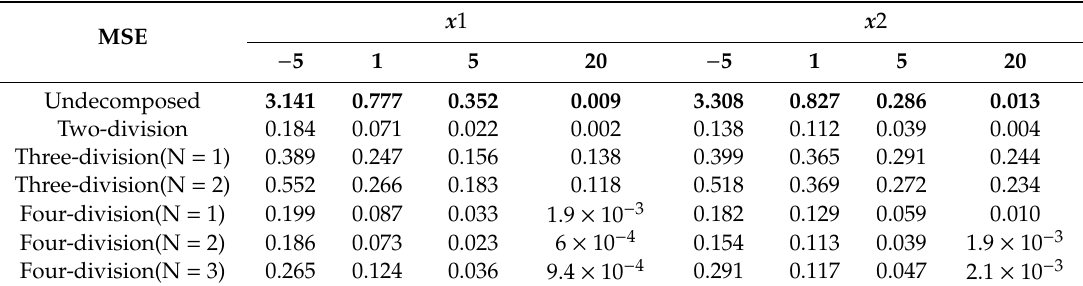
Table 2. The MSE of di ff erent noise reduction models.